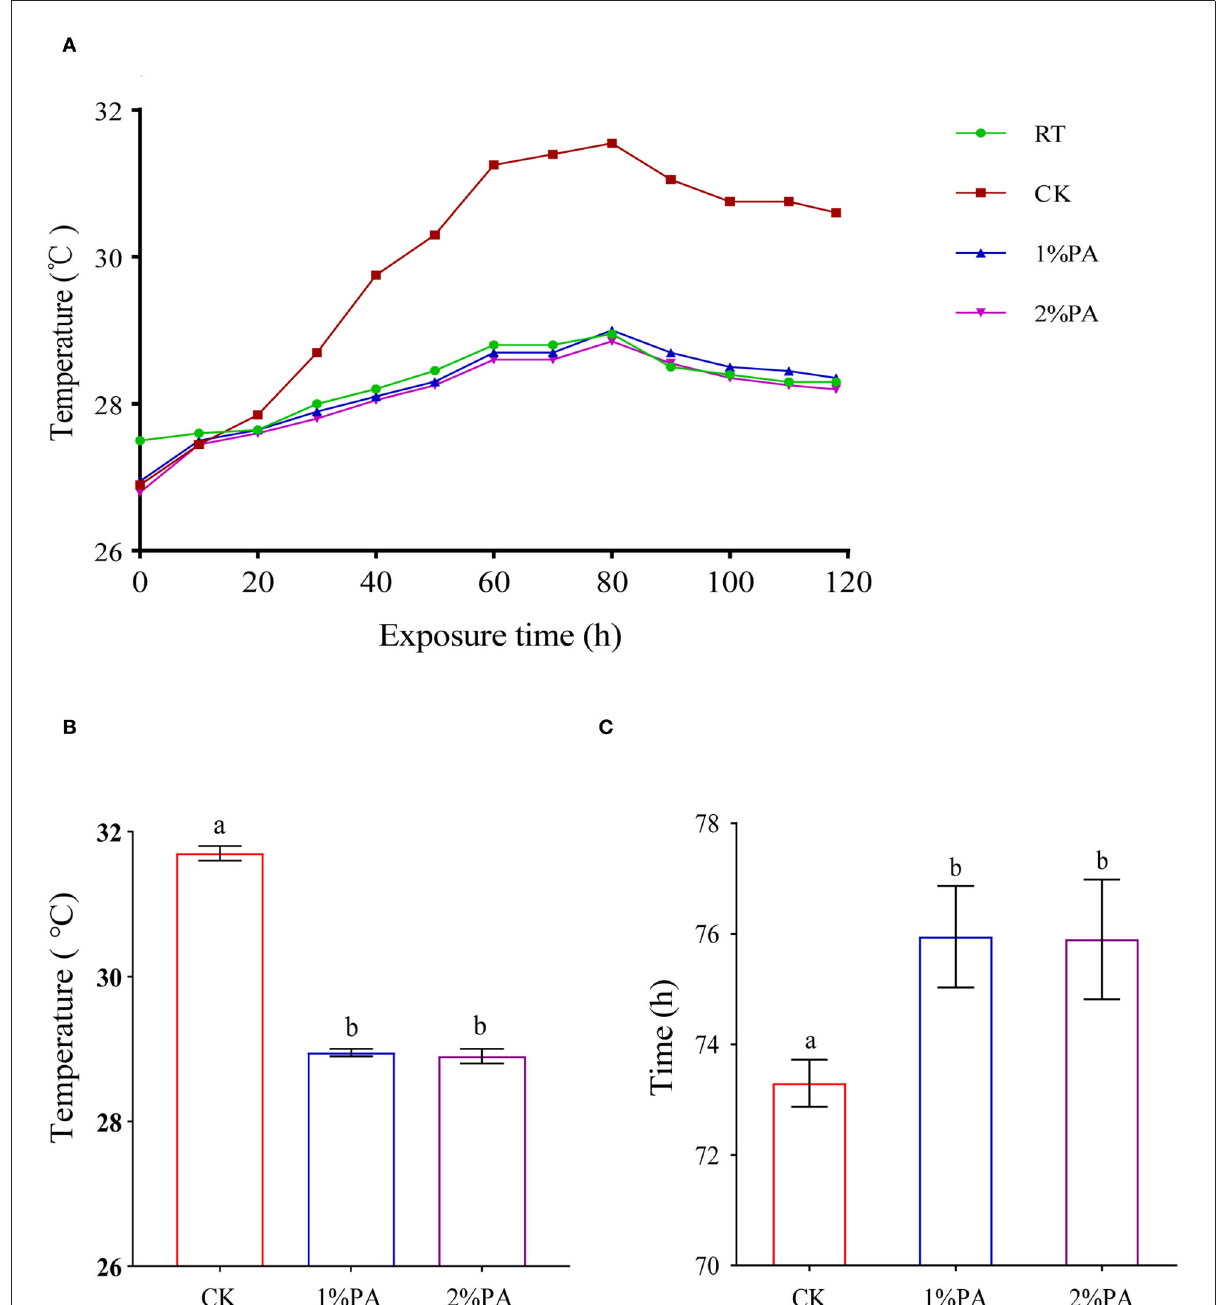
FIGURE1 (A) Aerobic stability of Napier grass silages with or without 1% and 2% pyroligneous acid during the 5-day aerobic test. (B) Maximum temperature attained within 5 days of aerobic exposure and (C) the time required.